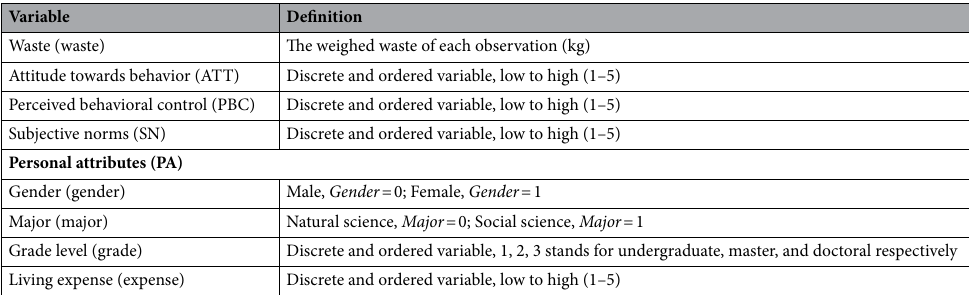
Table 2. Definitions of all the variables in regression analysis.